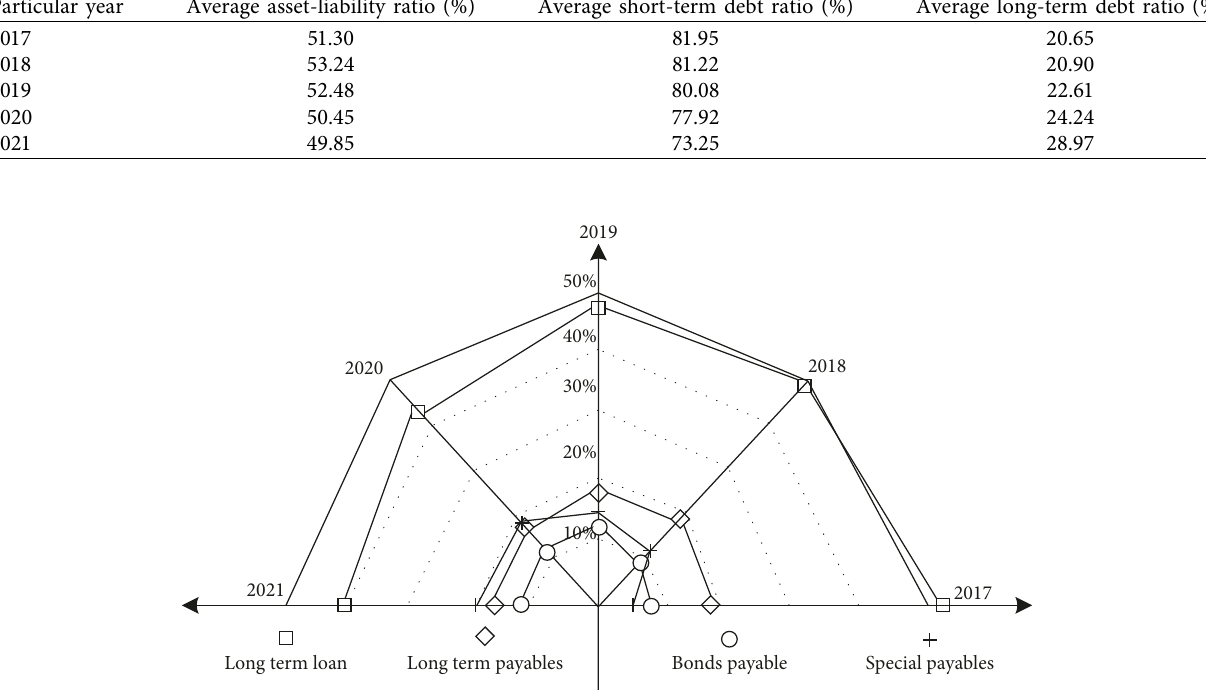
Figure 4: Structural proportion relationship of indicators in a long-term debt structure.